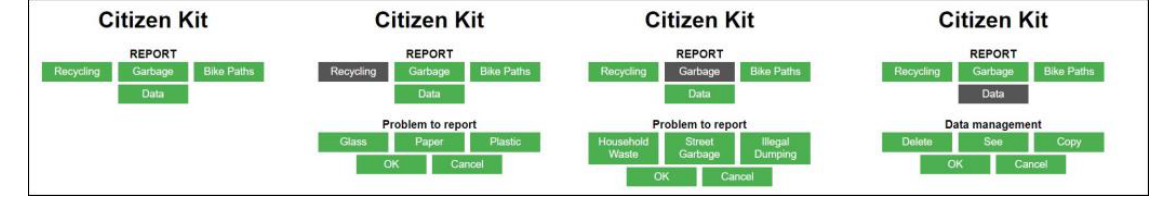
Figure 18. Web server HTML pages.